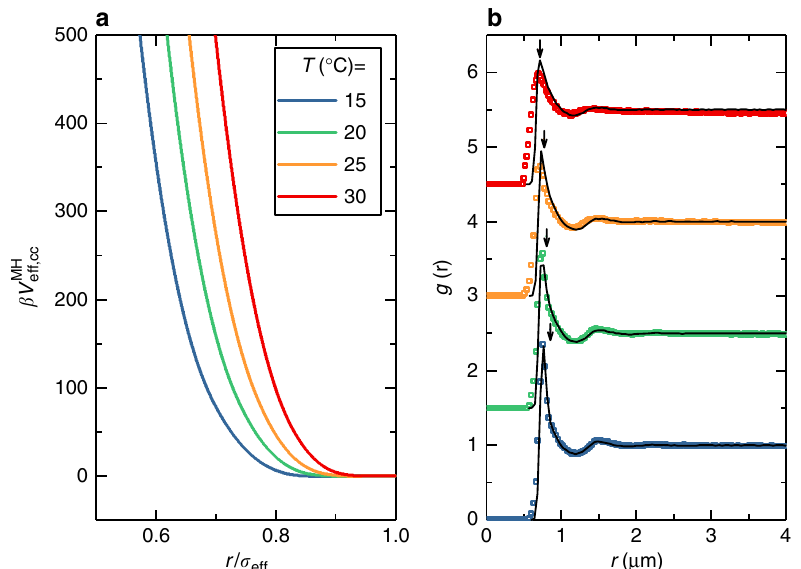
and resultant g ( r )s for one state point at different temperatures. a Calculated effective potential β V MH Fig. 6 Typical V MH eff ; cc dependent V MH and V cd . At T = 15 °C, β V MH displays a shallow negative minimum at (cid:3) (cid:2) 0 : 6 k cc eff ; cc and experimental g ( r )s (colored squares). From top to bottom temperature increases from 15 to 30 °C. Downward pointing arrows indicate the hydrodynamic diameter of colloids which does not generally coincide with the fi rst peak position at any